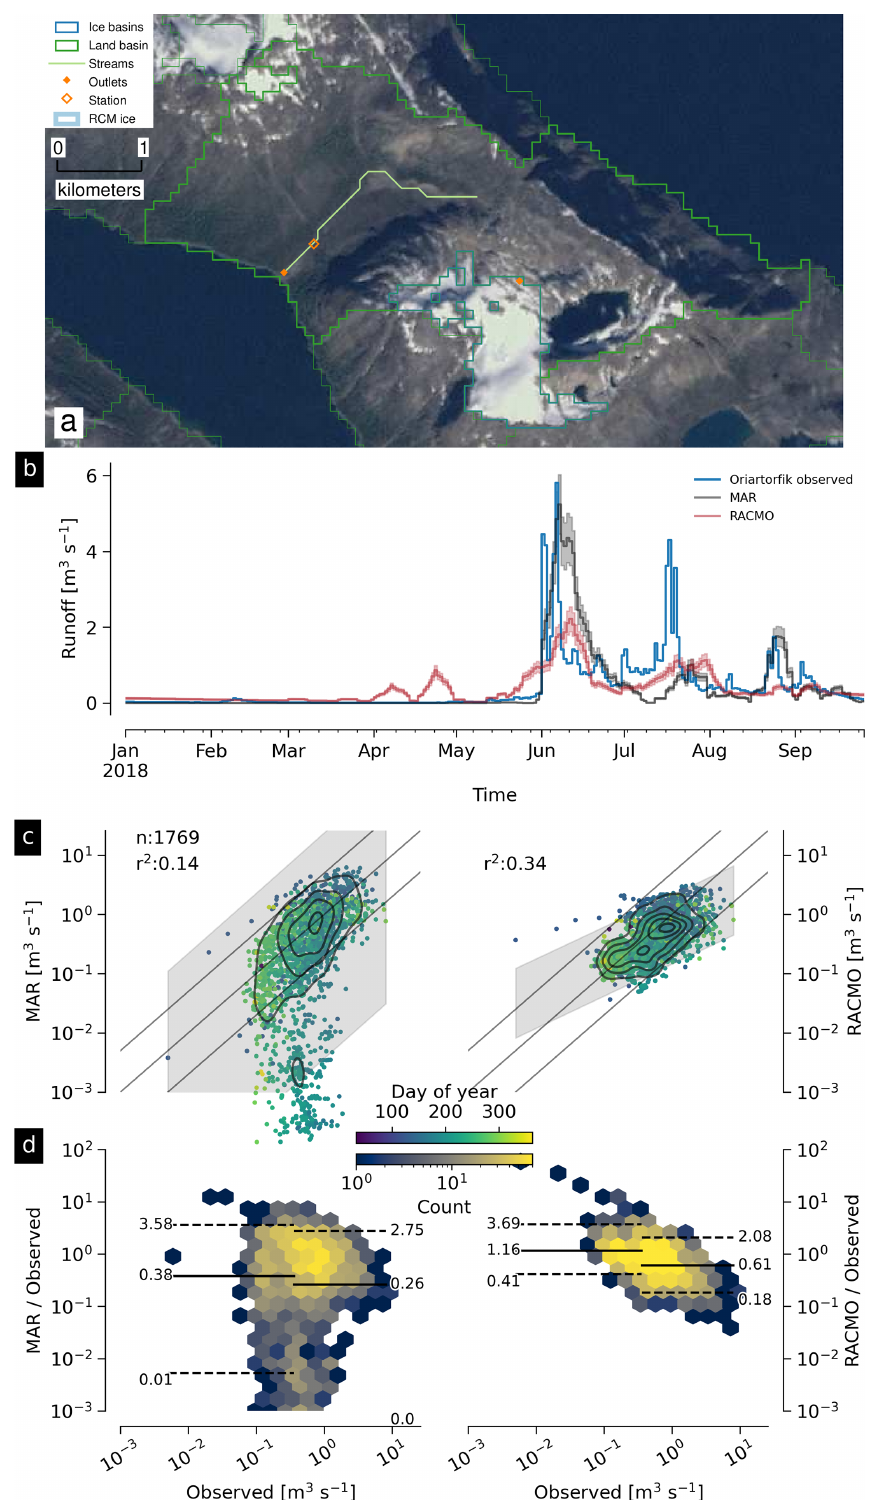
Figure 12. Graphical summary of Oriartorfik outlet, basin, and discharge (O in Fig. 1). See Sect. 3.4 for a general overview of graphical elements and Sect. 4.2.5 for discussion of the Oriartorfik basin. Basemap from Howat et al. (2014) and Howat